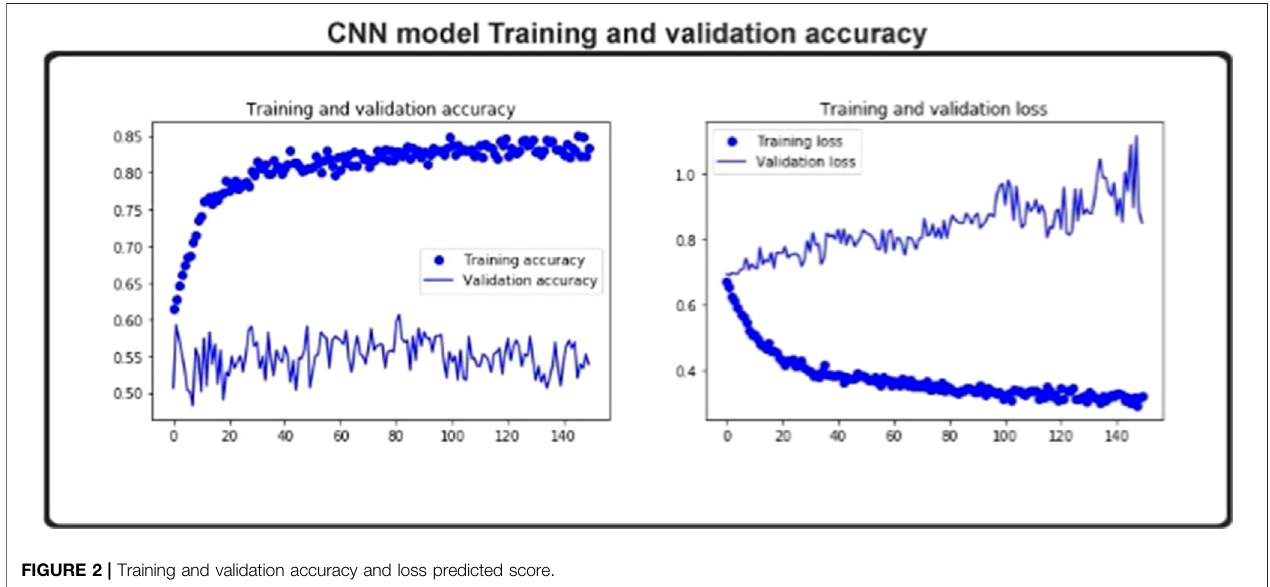
FIGURE 2 | Training and validation accuracy and loss predicted score.